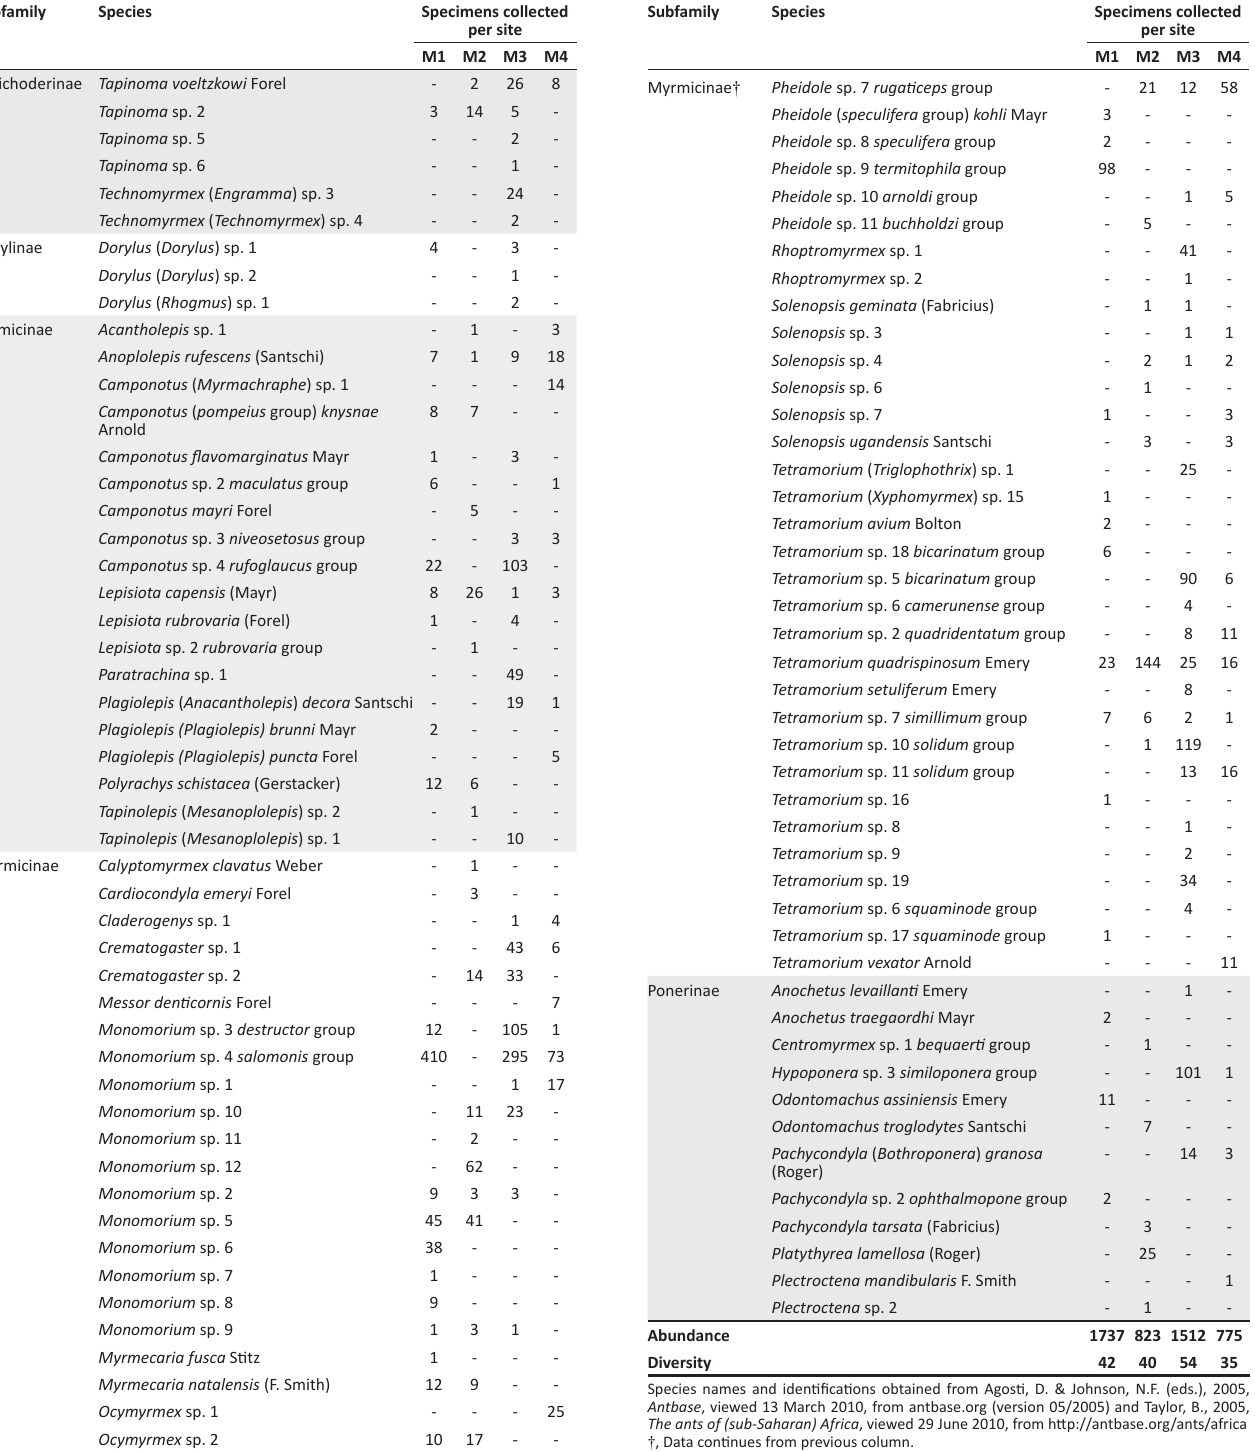
TABLE 2: Checklist of ants of the Marakele National Park, Limpopo province, South Africa. Subfamily Species Specimens collected Dolichoderinae Tapinoma voeltzkowi Forel Tapinoma sp. 2 Tapinoma sp. 5